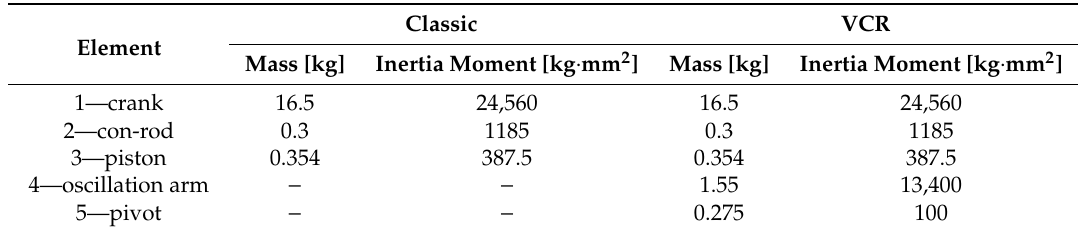
Figure 10. Pressure evolution on a cylinder used as input data in analyses ( a ) depending on crank speed; ( b ) depending on crank angle for a complete cycle ( c ) sketch of the engine [13]. Table 3. Dynamic input